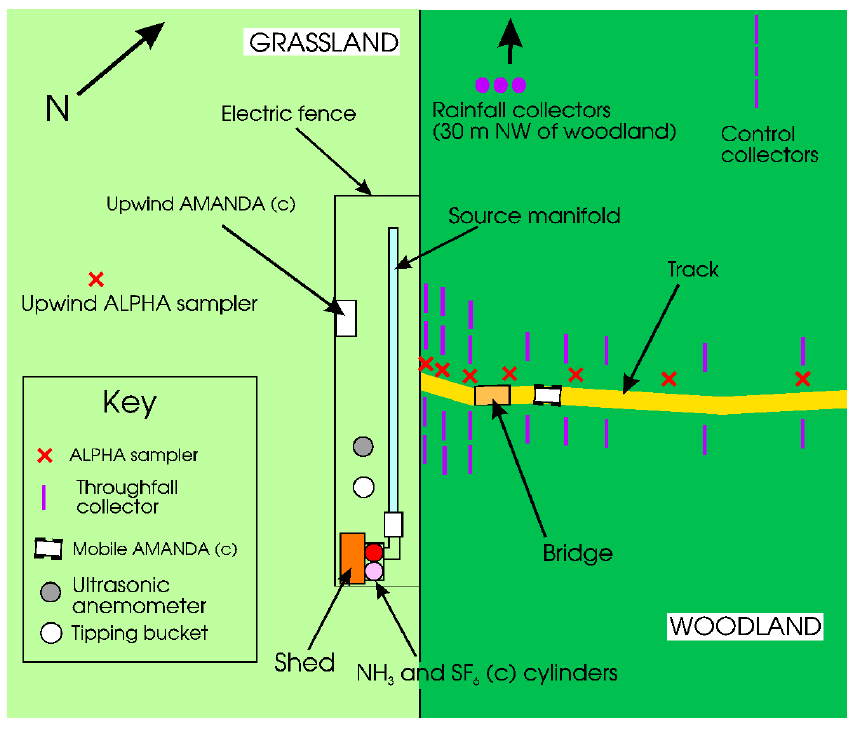
FIGURE 2. Layout of the experimental facility (not to scale). (c) indicates presence only during campaign